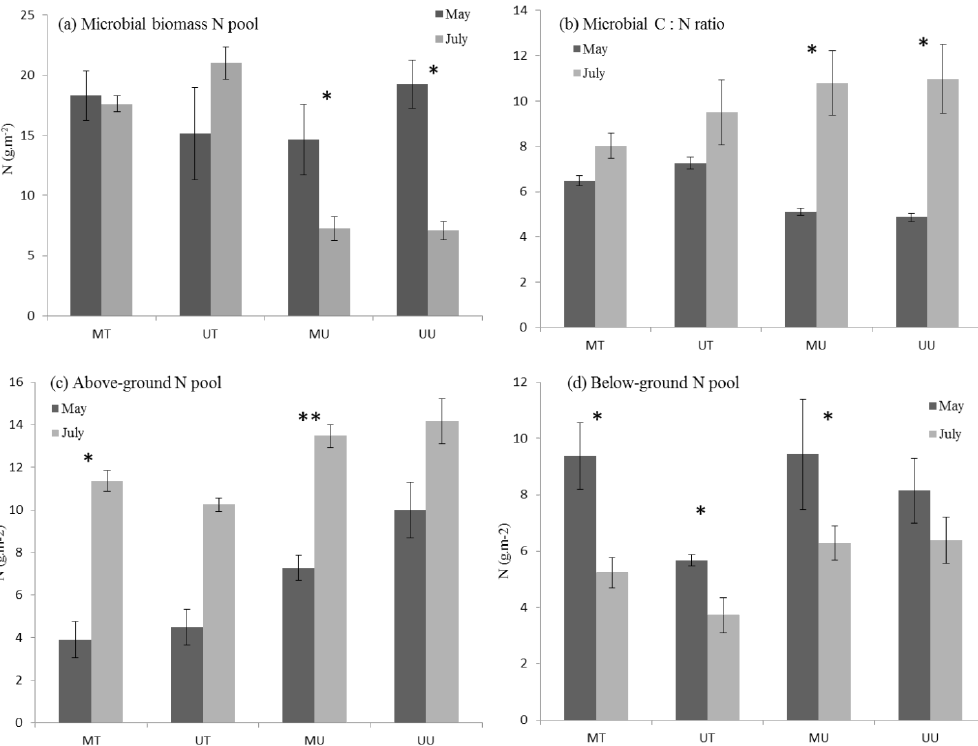
Fig. 2. Differences in soil microbial and plant nitrogen (N) pools between the end of snowmelt and the peak biomass in each subalpine Figure 2 agricultural grasslands with distinct land uses. (a) Microbial N pool and (b) microbial C:N ratio at the beginning of both experiments is calculated from the microbial N concentration x biomass per m − 2 . (c) Aboveground N and (d) root N pools at the beginning of the both experiments are calculated from leaf or root N concentration x biomass per m − 2 . Data from four 200cm 2 areas per fields were amalgamated to give mean values of three fields per land use ±SE. Statistical analyses were done separately for each land use and stars represent significant differences (* < 0 . 05; ** < 0 . 01 and *** < 0 .